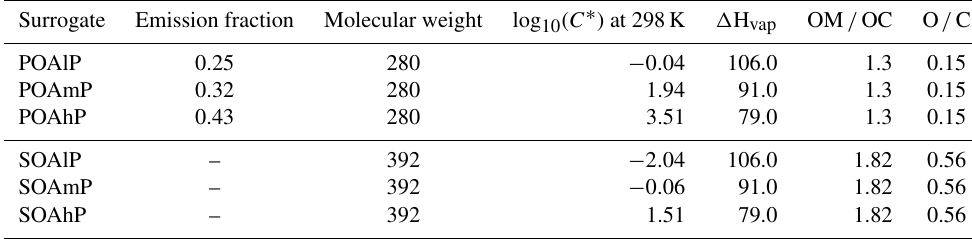
Table B1. Properties of the primary and secondary anthropogenic I/S-VOCs. The molecular weights are in gmol − 1 . (cid:49) H vap is the enthalpy of vaporization in KJmol − 1 , which describes the temperature dependance of the saturation pressure C ∗ .